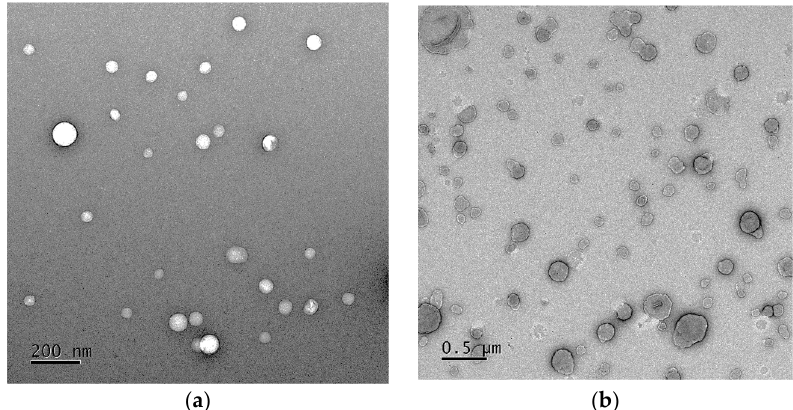
Figure 8. Representative transmission electron micrographs of ( a ) P. pyrifolia callus extract-loaded nanoliposomes (NLs) produced by nano-emulsification (PC-NLs) and elastic NLs containing callus extract (PC-ENLs). Scale bars in ( a , b ): 200 nm and 0.5 µm, respectively.